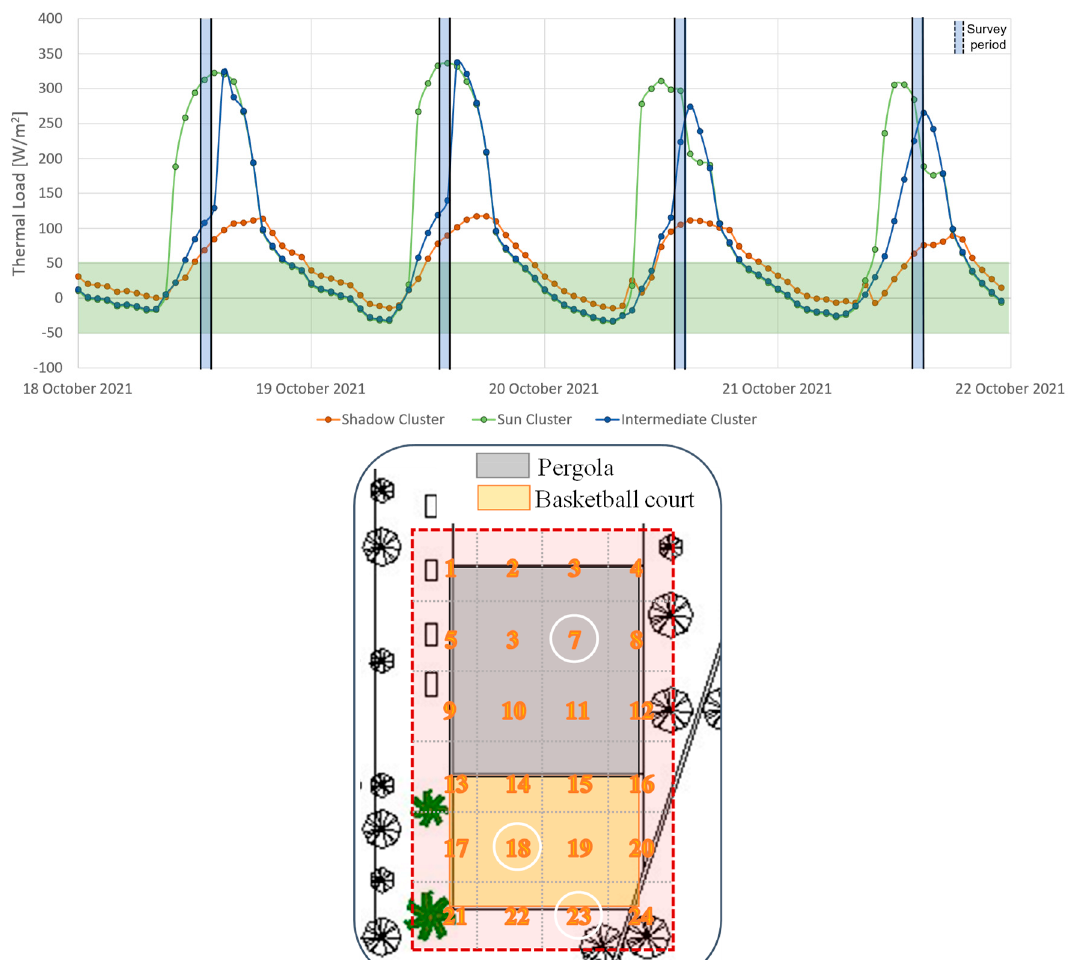
Figure 17. Thermal load calculated by the COMFA model.